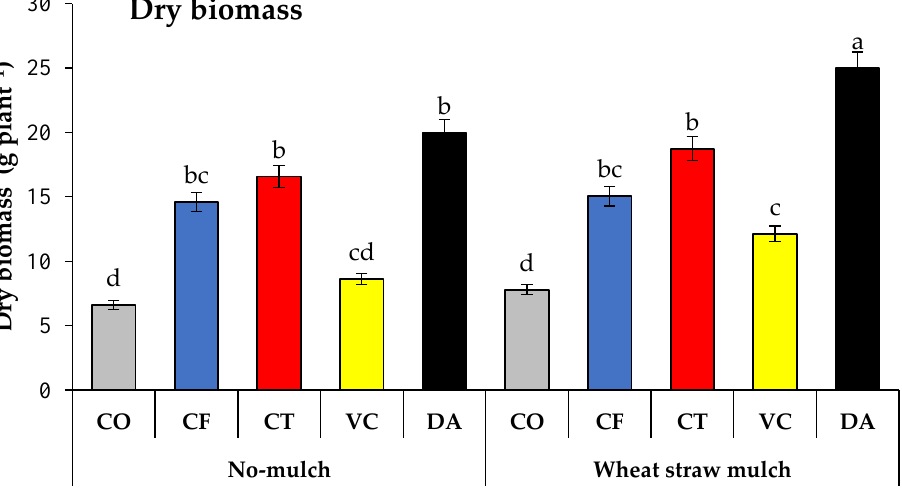
Figure 2. Effect of organic amendments and mulching system on the growth of squash plants. CO = Control (without fertilization), CF = Recommended mineral fertilization (112 kg N ha −1 + 50 kg P 2 O 5 + 75 kg K 2 O ha −1 ), CT = Compost (7.5 t ha −1 ), VC = Vermicompost (7.5 t ha −1 ), DA = Dry Azolla pinnata (3.75 t ha − 1 ). Different letters indicate significant differences according to Duncan’s multiple range test at p ≤ 0.05. Data are means of three replicates ± SE .